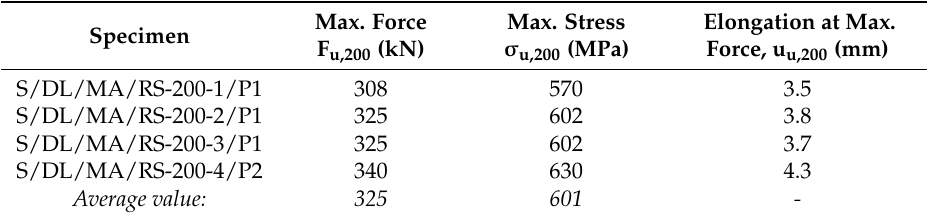
Figure 6. Relationship force—relative elongation of the specimens with the anchor length of 200 mm. Table 5. Static test results for the specimen with 200 mm anchorage.